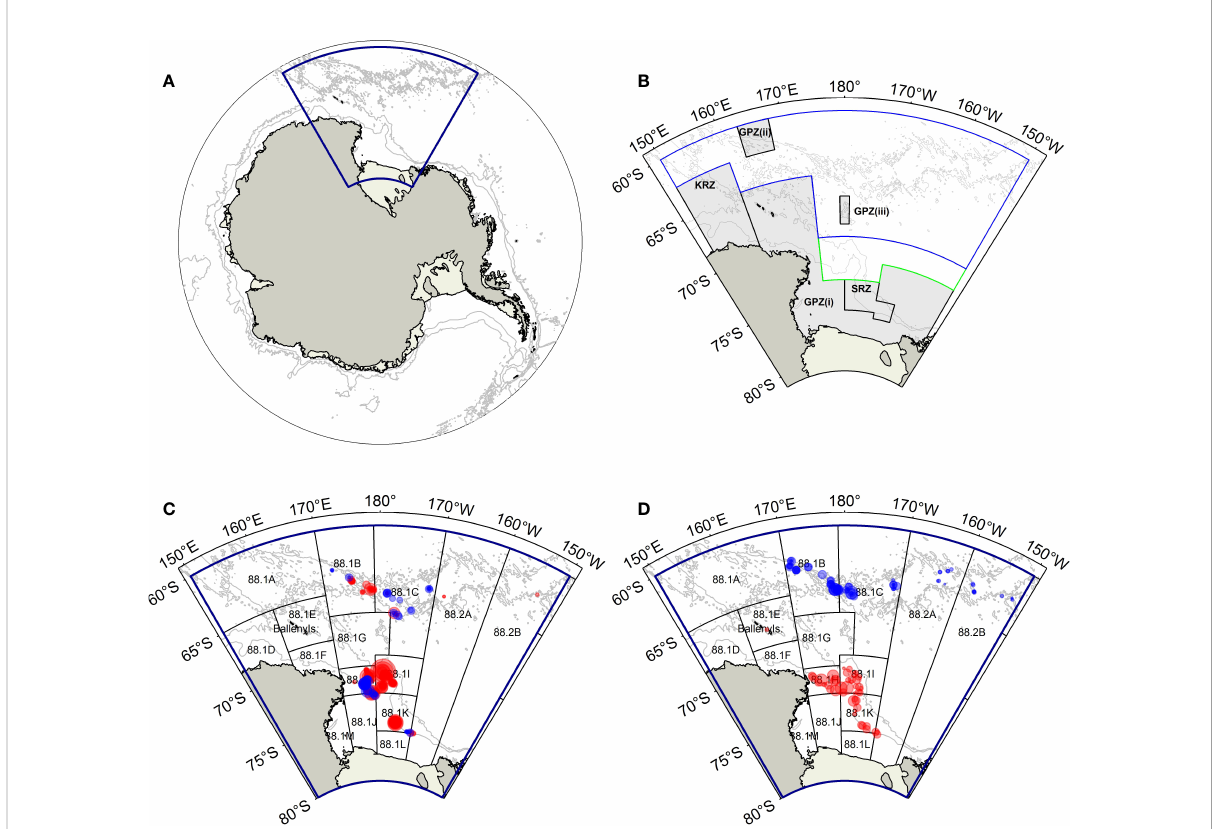
FIGURE 1 (A) The Antarctic continent, showing the Ross Sea region (RSR; blue polygon); (B) The RSR, showing the Ross Sea region Marine Protected Area (General Protection Zones (GPZ) (i) – (iii), the Krill Research Zone (KRZ), and the Special Research Zone (SRZ); in dark grey shade). The blue polygon delineates the N70 (North of 70°S) management area, while the green polygon delineates the S70 (South of 70°S) management area; (C) Sampling locations of Macrourus caml and M. whitsoni from the commercial fi shery between 2014 – 2021 (red circles) and Pinkerton et al. (2013) (blue circles); (D) Sampling locations of research trawl survey hauls in 2015 and 2019 (red circles) and the 2016 and 2019 winter surveys (blue circles). Also shown are the depth contours of 1000 m and 3000 m (all panels) and the CCAMLR small-scale research units (SSRUs) (panels C , D ). Circles sizes are proportional to sample sizes, with the largest circle representing ~200 sampled